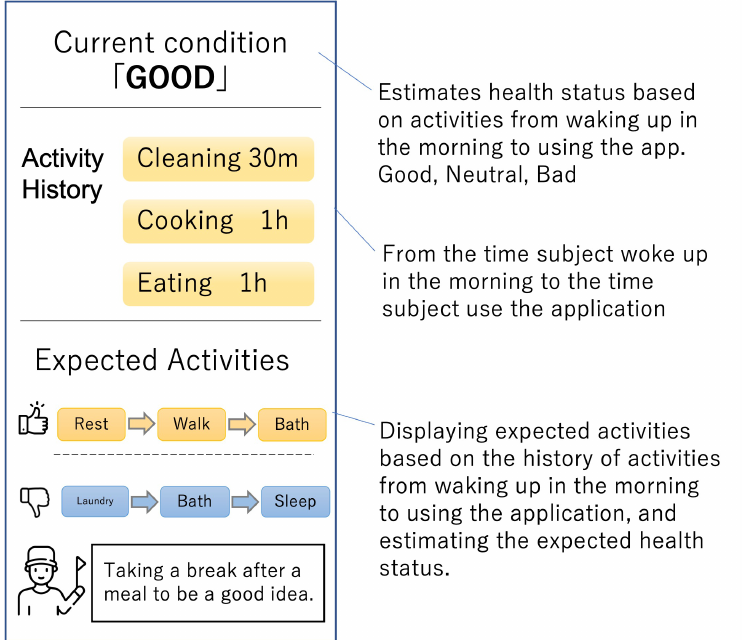
Figure 10. Mockup for future